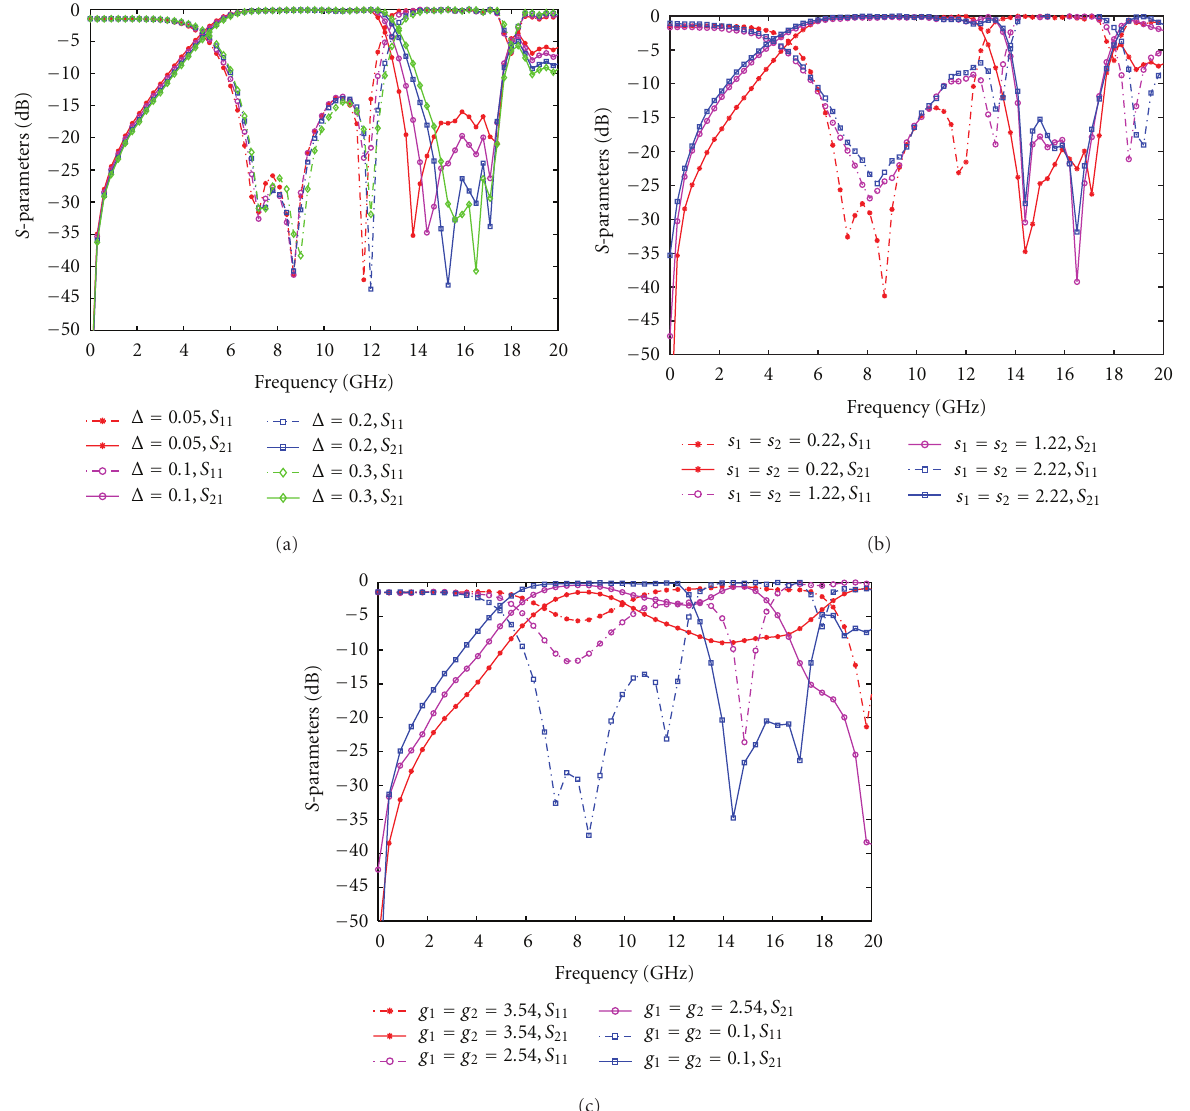
Figure 6: Parameterization of dimensions (a) Δ , (b) s 1 , s 2 , and (c) g 1 , g 2